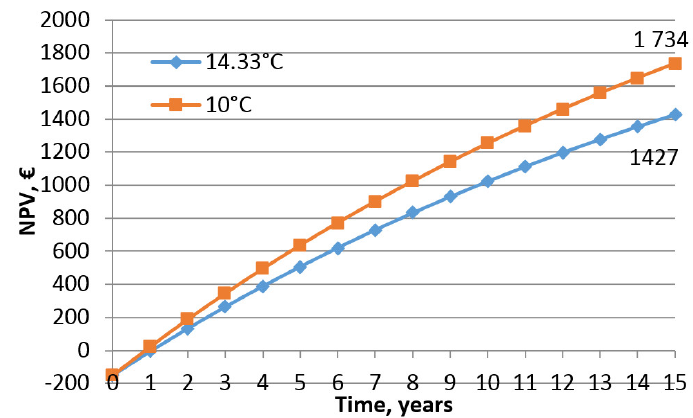
Figure 7. The impact of cold water temperature on the value of the NPV rate when using a HE_1 heat exchanger.